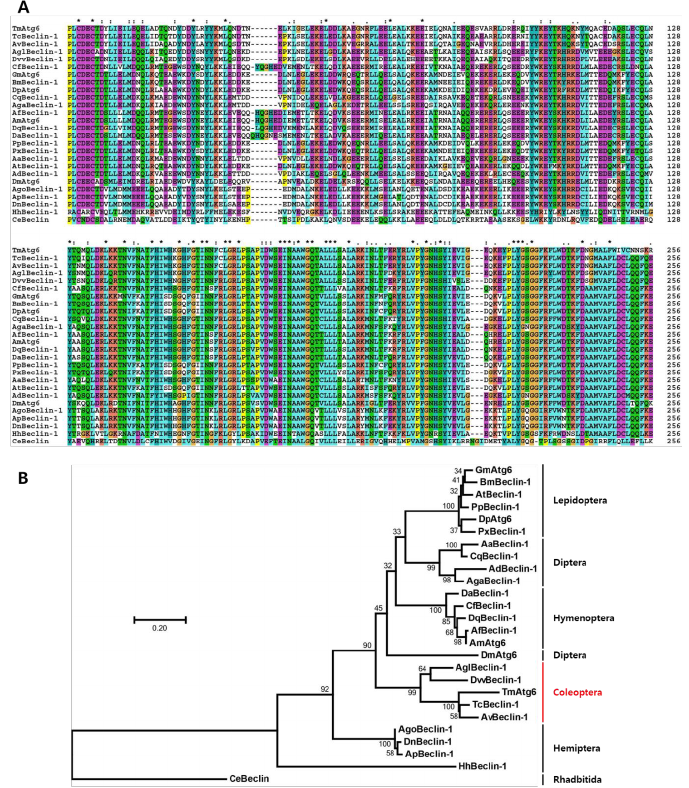
Figure 2. Multiple alignments and molecular phylogenetic analysis of insect beclin-1 homologs protein. ( A ) Multiple sequence alignment of Tm Atg6 along with its homologs. The highly conserved beclin-1 domain was aligned by using Clustal X2 software. The symbols indicate conservation scores between groups according to the Gonnet PAM 250 matrix (‘*’ > ‘:’ > ‘.’) and ‘−’ indicates internal or terminal gaps. ( B ) Phylogenetic analyses of Tm Atg6 homologs were performed based on the multiple alignments using the Clustal X2 and the phylogenic tree was constructed by MEGA7 programs using the maximum likelihood and bootstrapped of 1000 replications. The red color text with vertical line used to indicate the coleopteran order grouped together. Phylogenetic analysis of the Caenorhabditis elegans beclin-1 sequence was used as the outgroup. The following protein sequences were used to construct the phylogenetic tree. Tm Atg6 ( Tenebrio molitor Autophagy-related 6), Tc Beclin-1 ( Tribolium castaneum Beclin-1-like protein; EFA06871.2), Av Beclin-1 ( Asbolus verrucosus beclin-1-like protein; RZC37309.1), Agl Beclin-1 ( Anoplophora glabripennis beclin-1-like protein; XP_018570978.1), Dvv Beclin-1 ( Diabrotica virgifera beclin-1-like protein; XP_028144478.1), Ago Beclin-1 ( Aphis gossypii beclin-1-like protein; XP_027849435.1), Ap Beclin-1 ( Acyrthosiphon pisum beclin-1-like protein; XP_016661093.1), Hh Beclin-1 ( Halyomorpha halys beclin-1-like protein; XP_014275231.1), Dn Beclin-1 ( Diuraphis noxia PREDICTED: beclin-1-like protein; XP_015372132.1), Aa Beclin-1 ( Aedes aegypti AAEL010427- PA; EAT37604.1)’ Ad Beclin-1 ( Anopheles darling beclin-1; ETN63629.1), Ag aBeclin-1 ( Anopheles gambiae str. PEST AGAP003858-PA; EAA06006.4), Cq Beclin-1 ( Culex